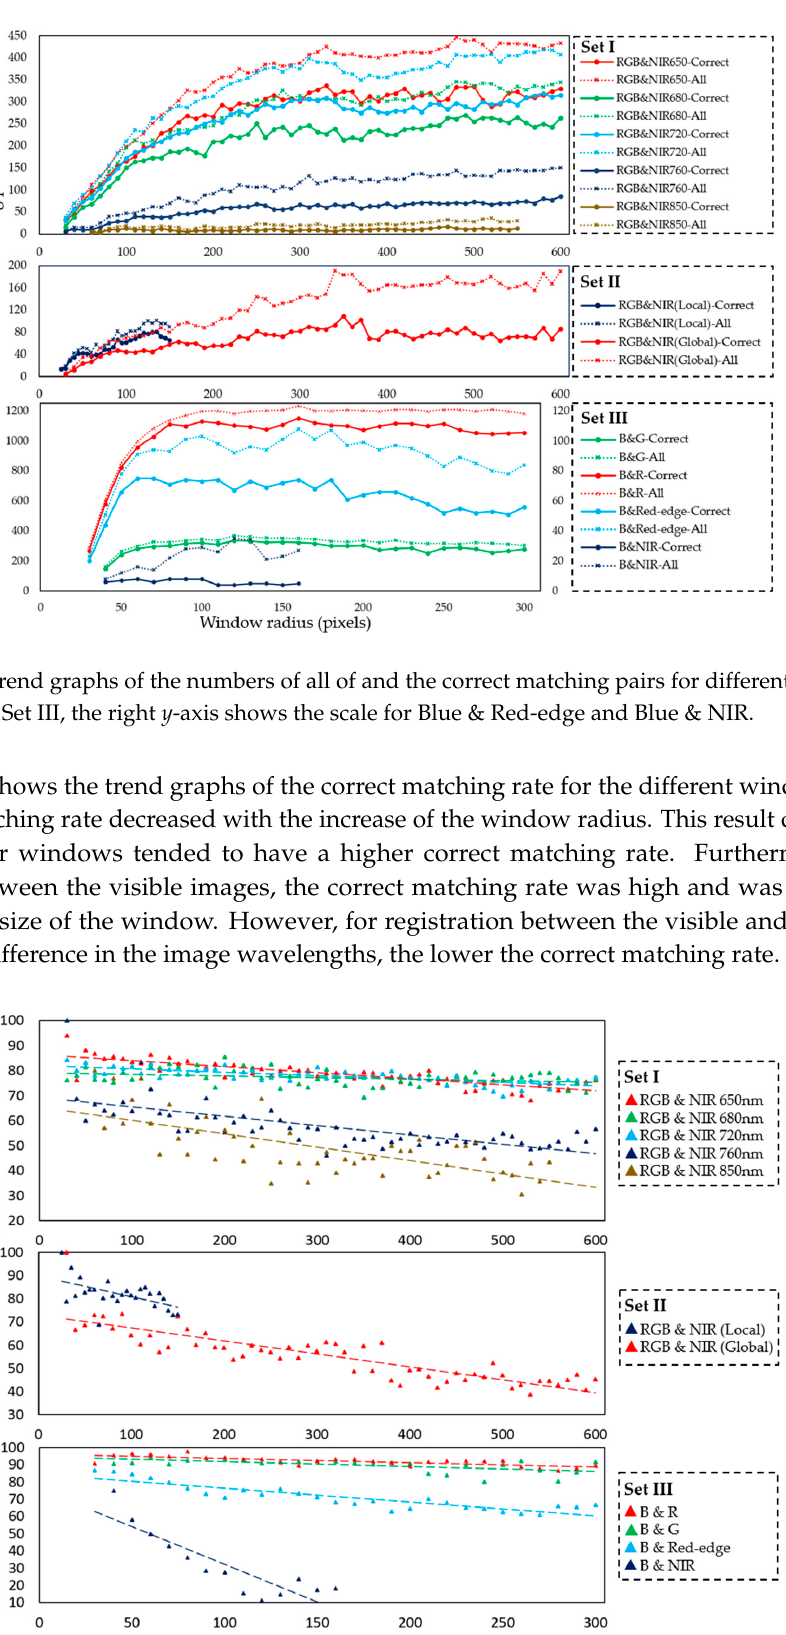
Figure 11. Trend graphs of the correct matching rate for the different window radiuses.